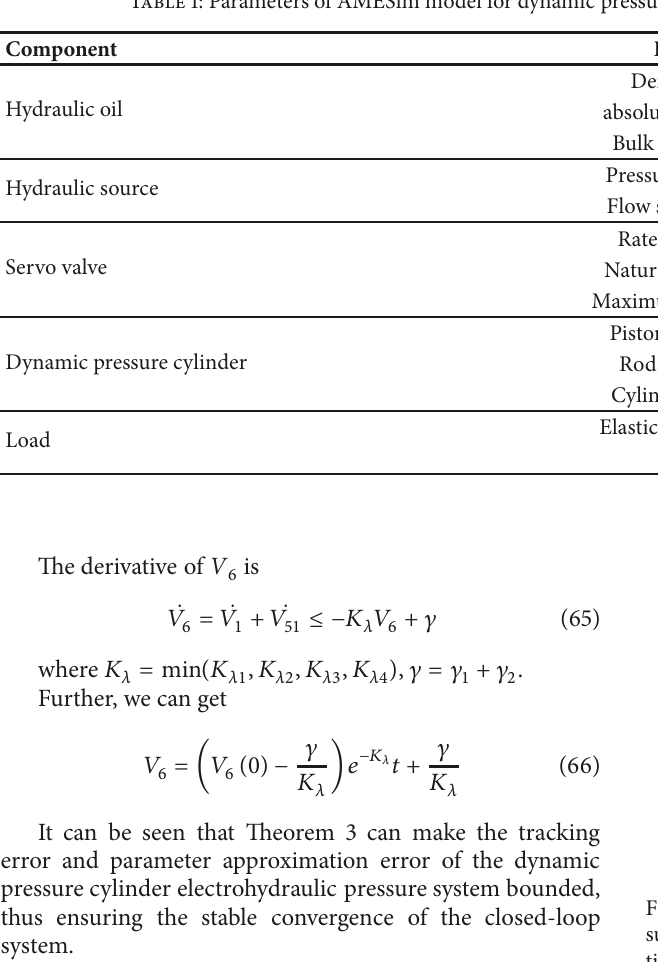
Table 1: Parameters of AMESim model for dynamic pressure cylinder electro-hydraulic servo pressure system.